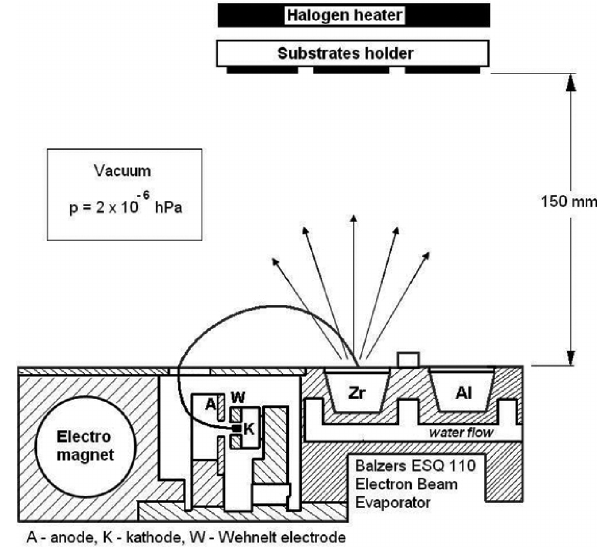
Fig. 3: Scheme of the apparatus of the EB-PVD method